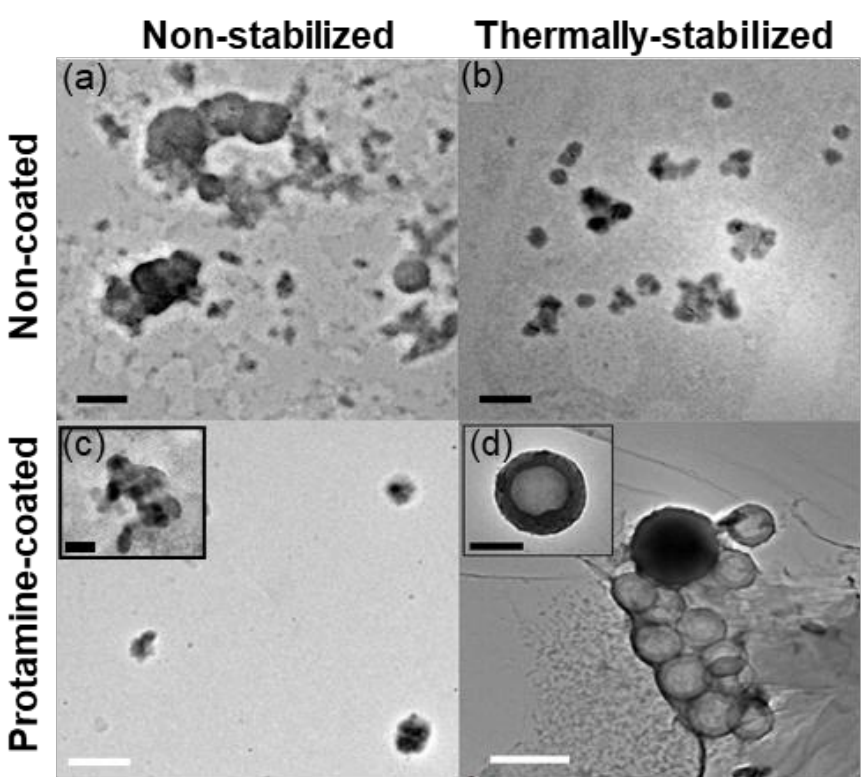
Figure 4. Transmission electron microscopy of unstained ( a ) CoAc ( b ) TS-CoAc ( c ) P-CoAc, ( d ) P-TS-CoAc, black bar = 200 nm, white bar = 500 nm.